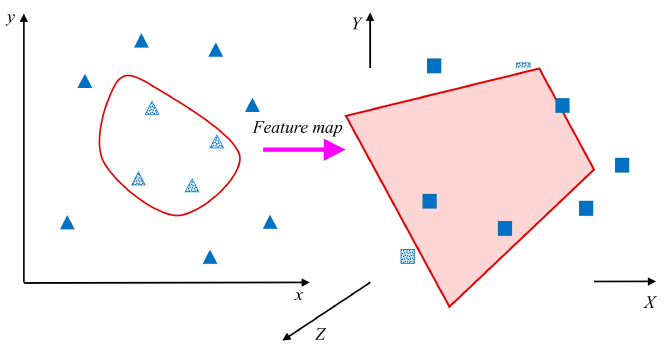
Figure 4. The mapping of feature vectors from a low dimension (shown as triangles) to a higher dimension (shown as